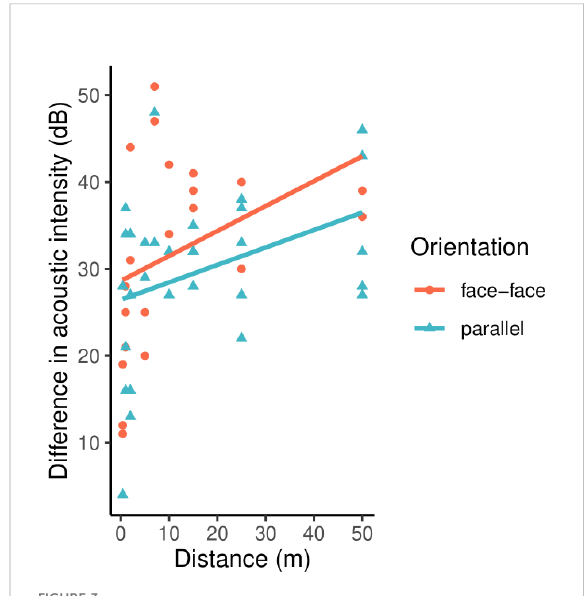
that the difference in acoustic intensity (measured on the maximum amplitude recorded on the signal) increases as the distance separating individuals increases, regardless of the orientation.